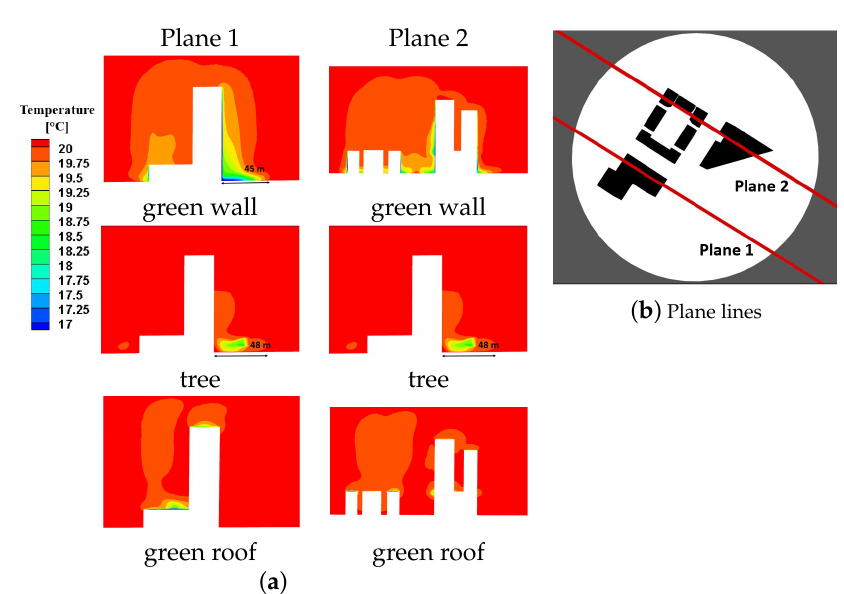
Figure 10. ( a ) Contours of temperature at different planes for scenario 4 using green walls, trees and